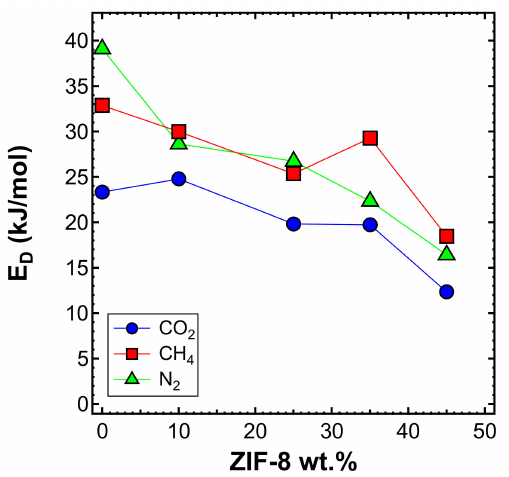
Figure 21. Activation energy of di ff usion measured in the interval 35–65 ◦ C for CO 2 , CH 4 , and N 2 in the MMMs as a function of filler loading.